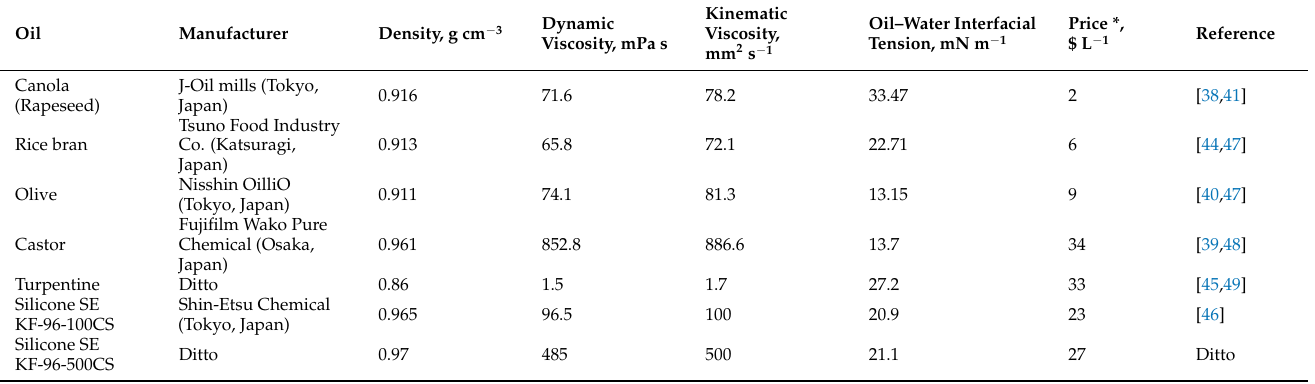
Table 2. Properties of selected